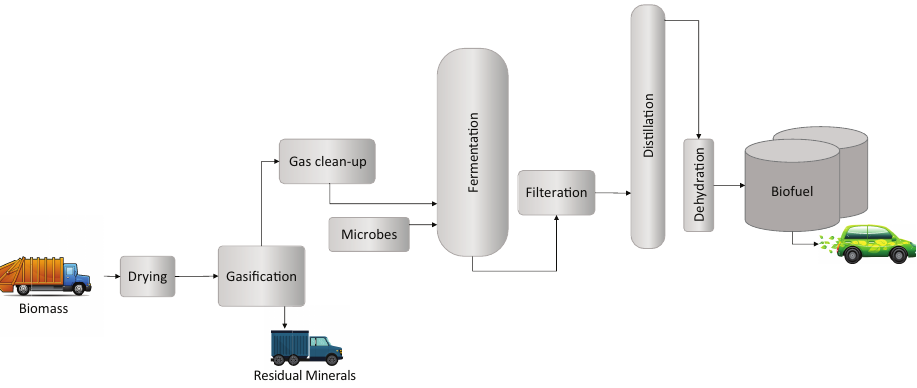
Figure 1. Sketch of a representative bio processing plant (inspired by Aylott [30]).